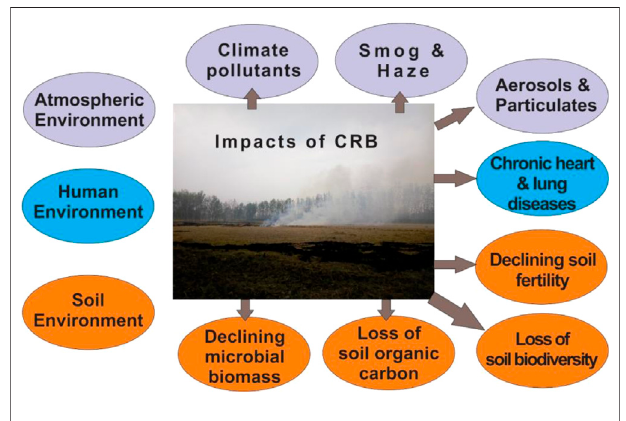
FIGURE 1 | Impacts of crop residue